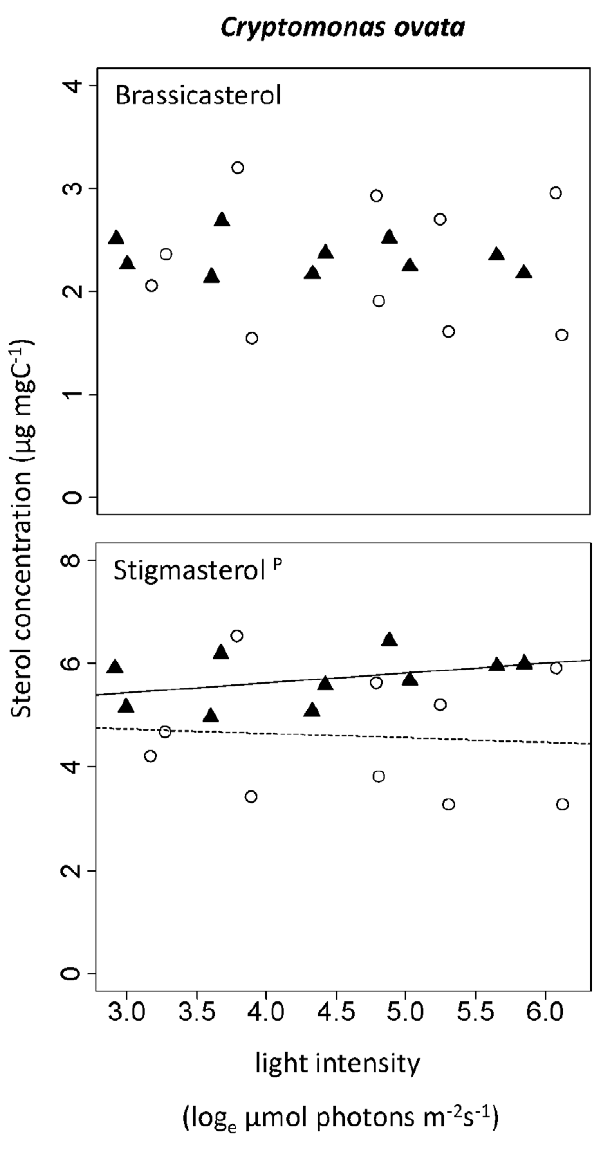
Figure 3. Change in sterol content with light intensity in Cryptomonasovata . ( m , straight line) High-P treatments. ( # , dashed line) Low-P treatments. Superscripts indicate statistically significant effects of light intensity (l), phosphorus supply (P), or interaction of these two factors (l*P). A regression line was added if one of the effects was